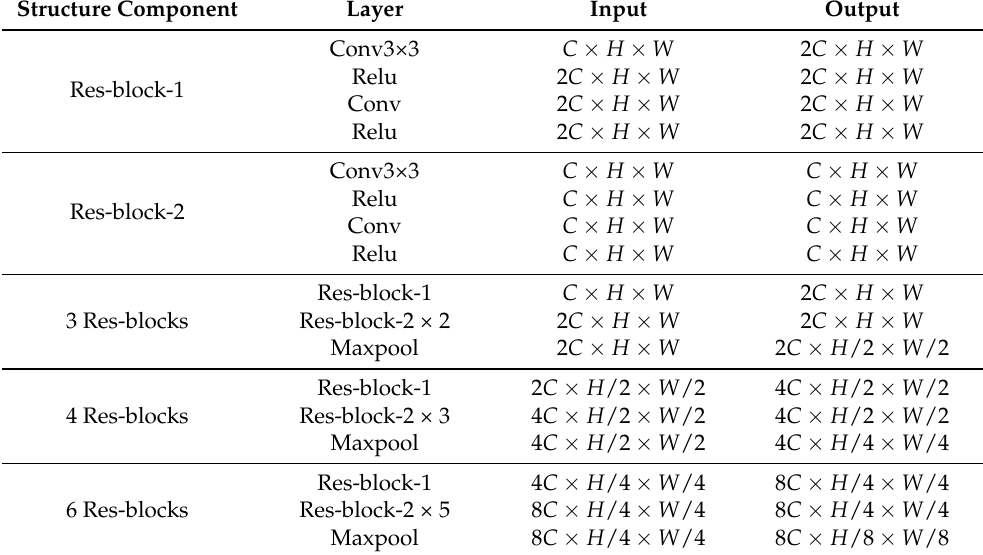
Table 1. Detailed network parameter settings of FEE, where H and W imply the height and width of the feature map, while C denotes the channel number. In this table, Res-block-1 and Res-block-2 are parts of Res-blocks. FEE is composed of 3 Res-blocks, 4 Res-blocks, and 6 Res-blocks. Structure Component Layer Input Output Conv3×3 C × H × W 2 C × H × W Relu 2 C × H × W 2 C × H × W Res-block-1 Conv 2 C × H × W 2 C × H × W Relu 2 C × H × W 2 C × H × W Conv3×3 C × H × W C × H × W Relu C × H × W C × H × W Res-block-2 Conv C × H × W C × H × W Relu C × H × W C × H × W Res-block-1 C × H × W 2 C × H × W 3 Res-blocks Res-block-2 × 2 2 C × H × W 2 C × H × W Maxpool 2 C × H × W 2 C × H /2 × W /2 Res-block-1 2 C × H /2 × W /2 4 C × H /2 × W /2 4 Res-blocks Res-block-2 × 3 4 C × H /2 × W /2 4 C × H /2 × W /2 Maxpool 4 C × H /2 × W /2 4 C × H /4 × W /4 Res-block-1 4 C × H /4 × W /4 8 C × H /4 × W /4 6 Res-blocks Res-block-2 × 5 Maxpool 8 C × H /8 × W